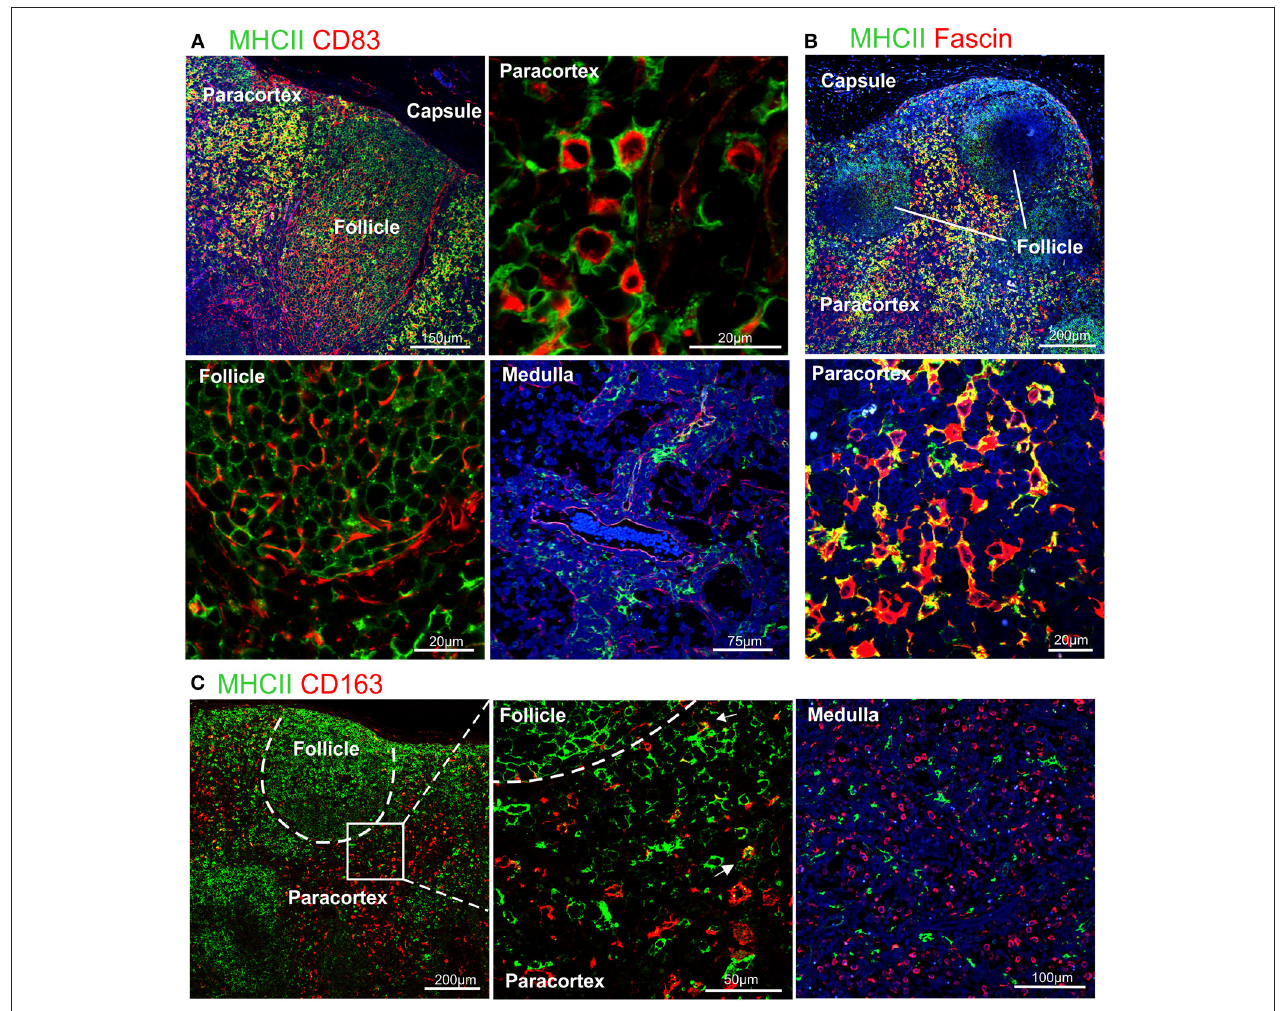
FIGURE 3 | Differential expression of MHC II in dendritic cells and macrophages. Representative confocal micrographs of sheep lymph node sections. (A) Sections stained for MHC II (green) and CD83 (red). (B) Sections stained for MHC II (green) and fascin (red) to visualize the extension of DCs in the paracortical area. (C) Sections stained for MHC II (green) and CD163 (red). Markers expression in different areas of the lymph node is shown at higher magnification, DAPI